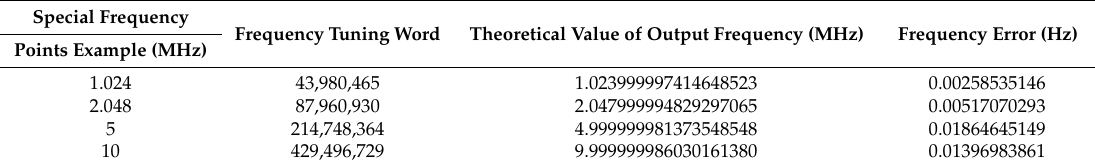
Table 1. Output capability of traditional DDS in special frequency points.